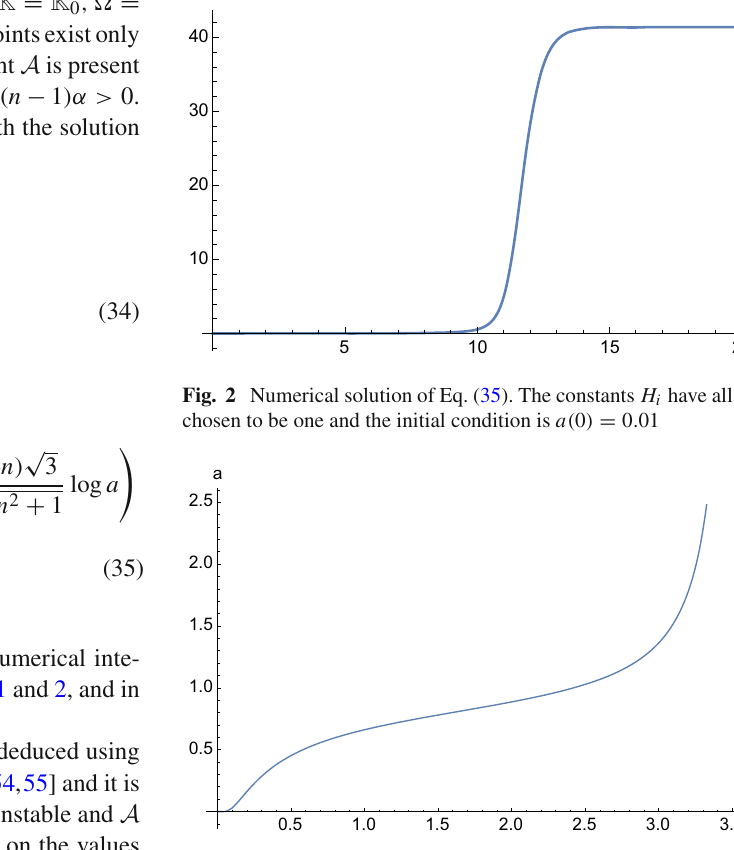
Fig. 3 Numerical solution of Eq. (27). The constants H i have all been > 0 and the initial condition chosen in such a way that 4 H 0 H 2 − H 2 1 is a ( 0 ) = 0 . 01. The solution presents a finite time singularity. If the above condition is violated the solution approaches a static universe as in the case of (34) and